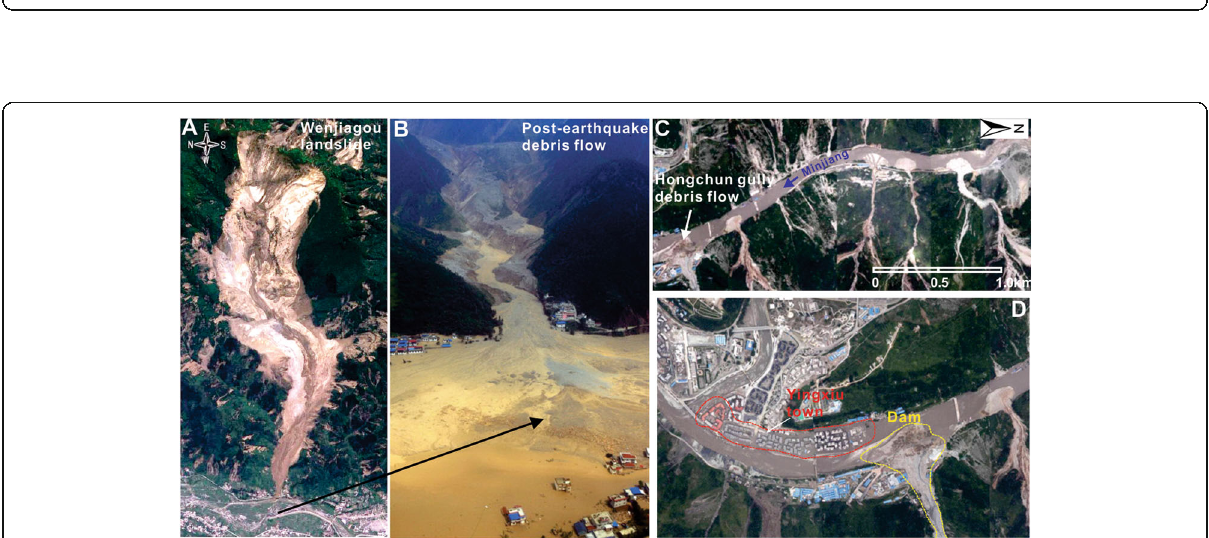
Fig. 11 Rock falls. a Shallow rock falls initiating from the upper part of slopes; b Rock falls interrupted tributaries; c A damming rock fall; d Aerial photo of the Dongjia rock fall; e Overview photo of the Dongjia rock fall and f Typical profile of the Dongjia rock fall